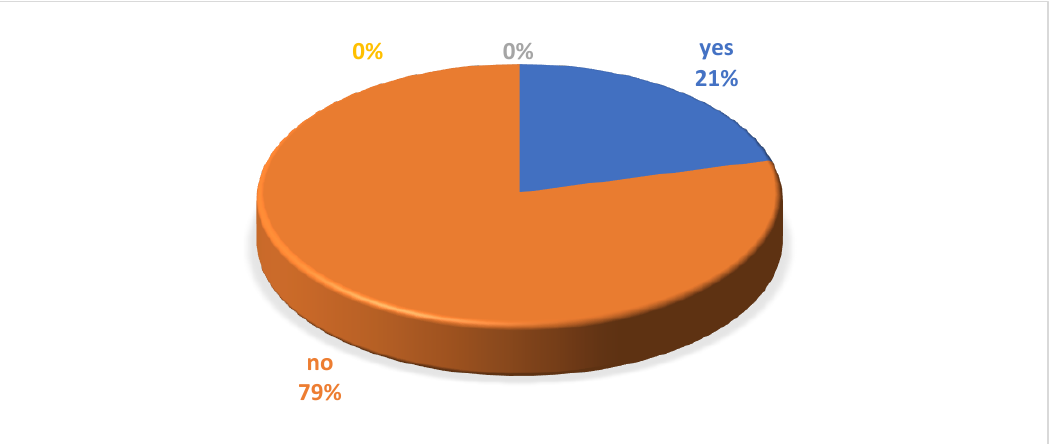
Figure 9. Interest in tools to switch to cleaner rolling stock (car purchases).